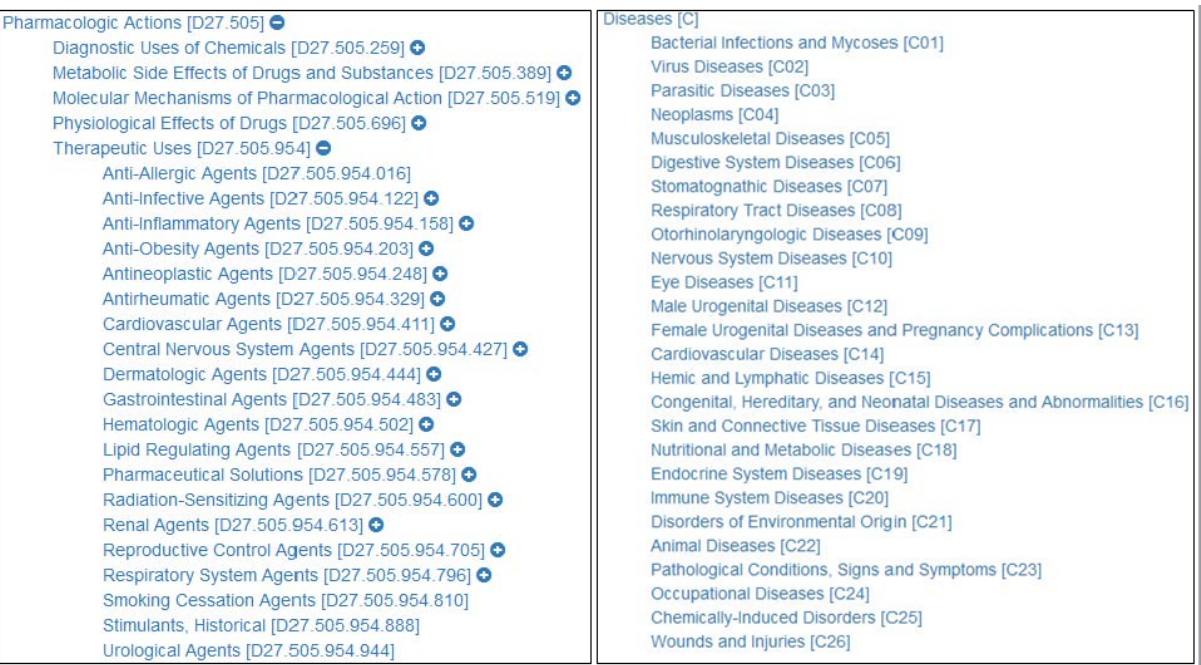
Figure 1. Automatic filtering of pharmacologic actions (left) and generic disease names (right).